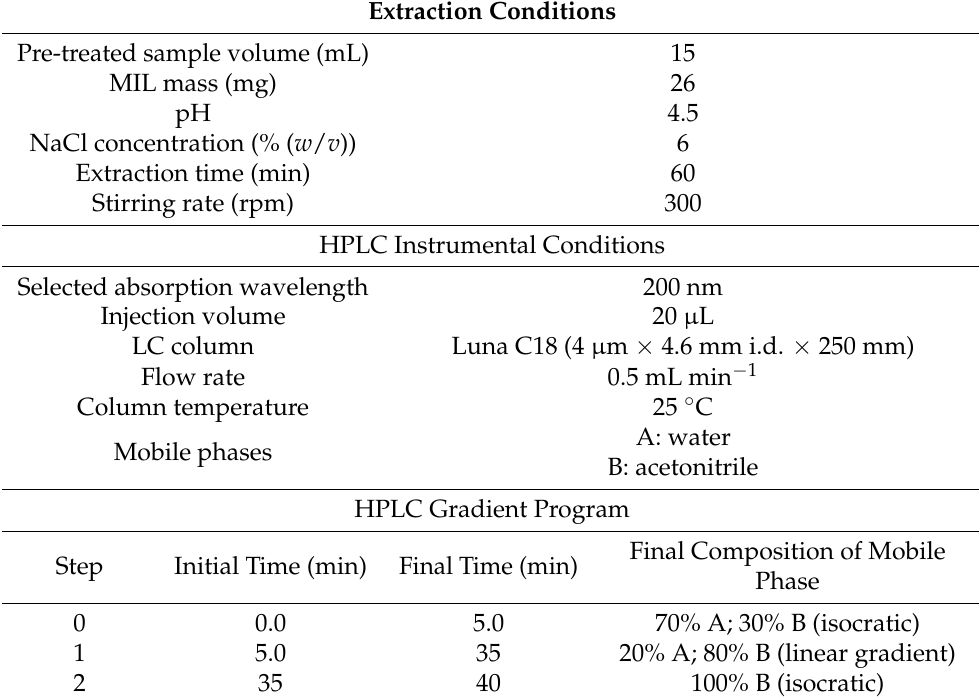
Table 4. Experimental and instrumental conditions for estrogens